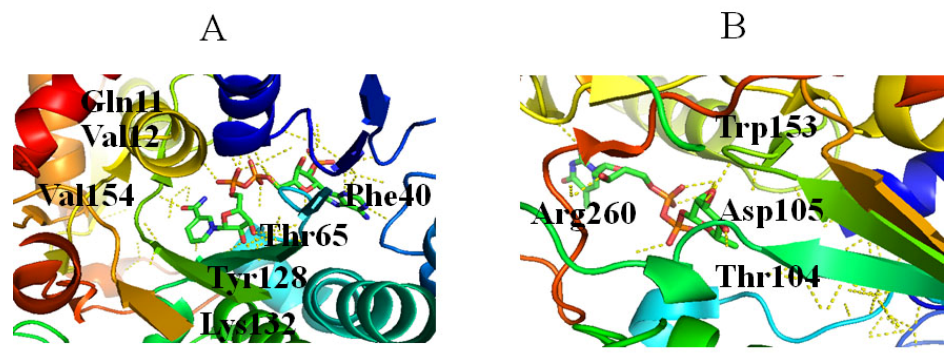
Figure 6. Stereo view of RmlD bound to NADH (PDB entry 1KC3) ( A ) and dTDP-Rha (PDB entry 1KC3) ( B ). Hydrogen bonds are shown as red lines. Helices, sheets, and loops of RmlD are colored blue, purple, and beige, respectively. C, N, O, and P elements of ligands are green, blue, red, and brown, respectively. RmlD is shown in cartoon representation, and ligands are shown as sticks [22].